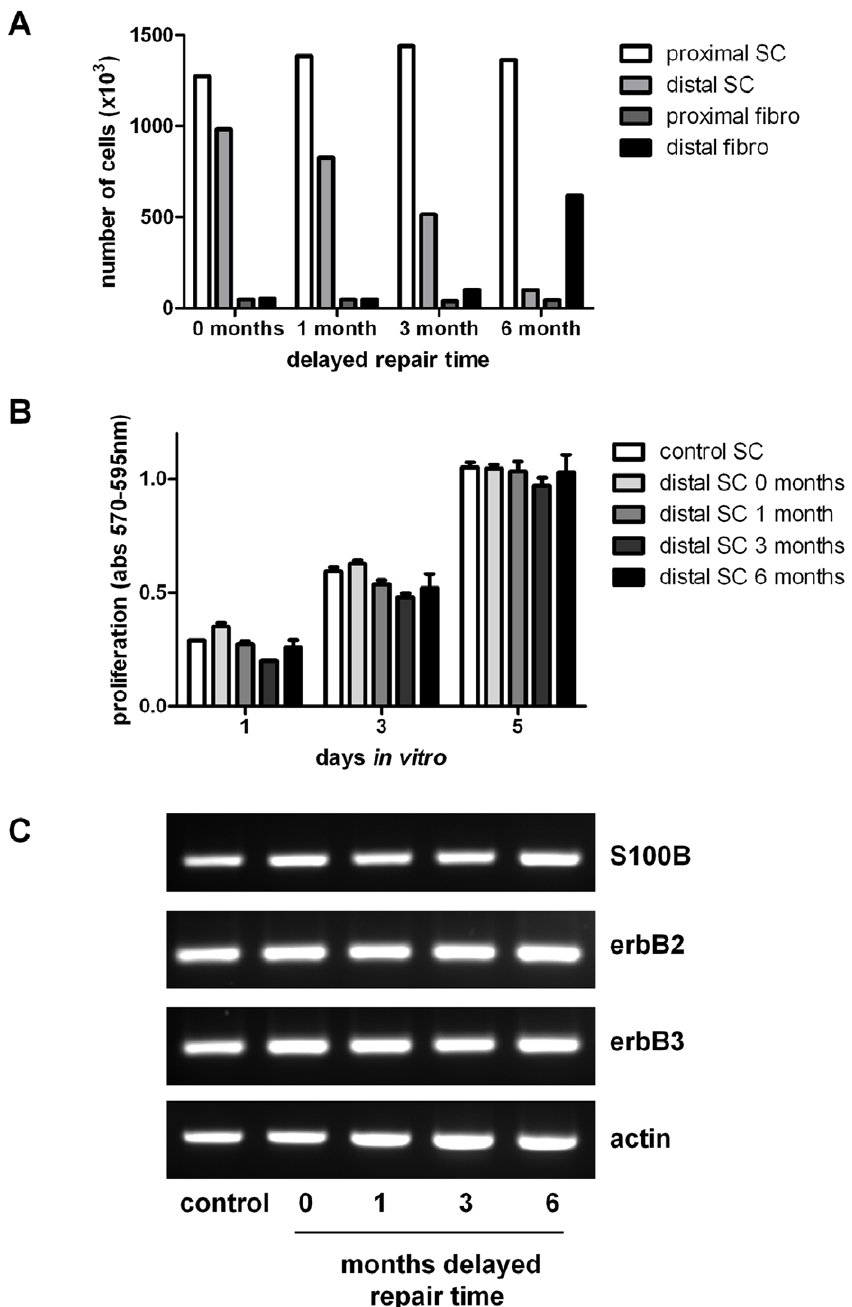
Figure 5. Characterisation of Schwann cells isolated from nerve segments. (A) The number of Schwann cells from proximal and distal nerve stumps of animals undergoing sciatic nerve injury followed by either immediate or delayed nerve repair (at the time points indicated) with a 10 mm graft were counted 7 days following enzyme digestion of the nerve. Fibroblast counts were also made following treatment of the samples with magnetic anti-fibroblast beads. (B) Distal nerve segment Schwann cells from (A) were trypsinised and replated and proliferation rates (in the presence of glial growth factors) compared with control normal cultures of Schwann cells (no experimental injury or repair). (C) Qualitative RT-PCR analysis of Schwann cell marker S100 and the glial growth factor receptors erbB2 and erbB3 expression levels in cultured cells isolated from control nerve (no experimental injury or repair) and the distal nerve segments of animals undergoing immediate (0 months) or delayed nerve repair (1, 3, 6 months). Actin was used as a house-keeping